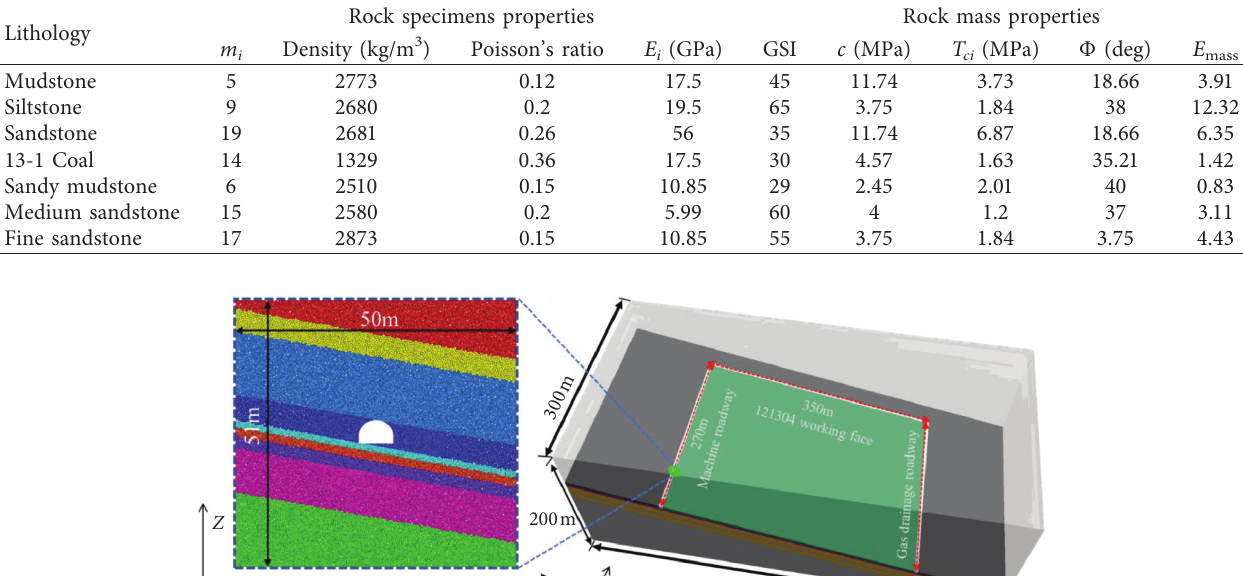
Table 1: Rock material and mass properties.